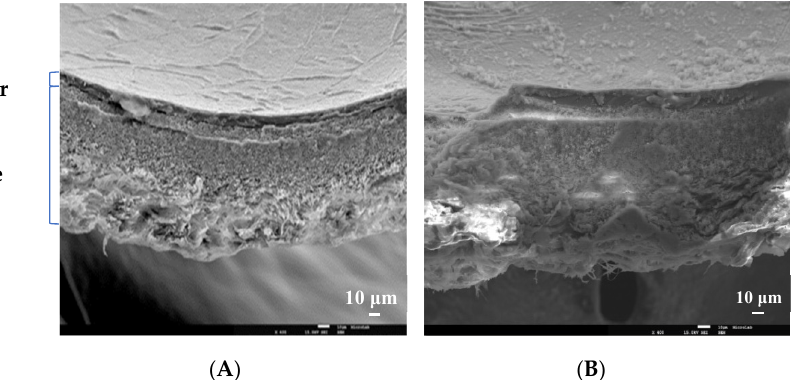
Figure 9. Scanning Electronic Microscopy (SEM) images of the cross-section of the chitosan modified membranes, cs-PES MFO22, obtained ( A ) before and ( B ) after filtration of the synthetic tannery effluent.